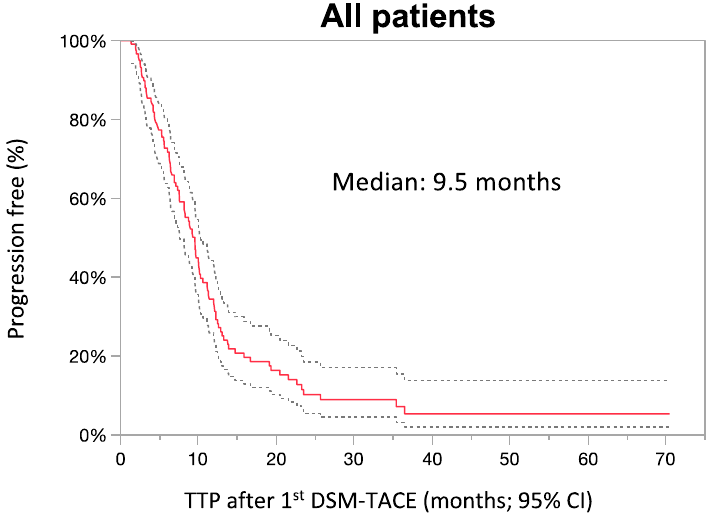
Figure 3. Time to progression (TTP) after the first treatment. TTP of all patients following the first DSM-TACE treatment incl. 95% confidence interval (95% CI).